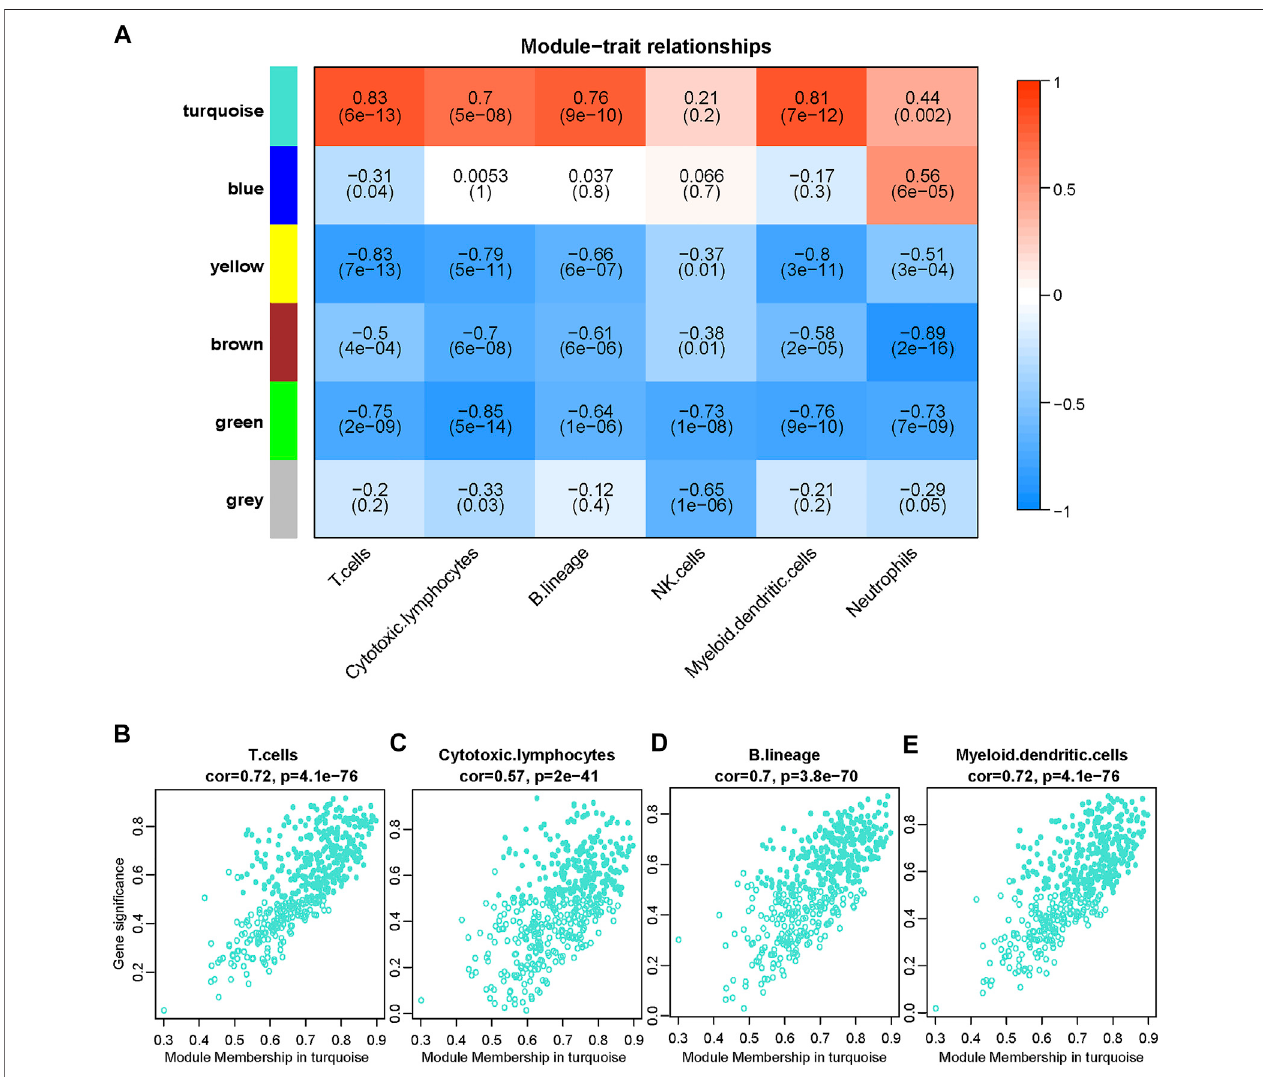
FIGURE 4 | Screening candidate immune-related DN biomarkers using WGCNA. (A) Correlation between the gene module and in fi ltrated immune cell population, which signi fi cantly differed between the DN and healthy samples. The correlation coef fi cient in each cell represented the correlation between the gene module and the in fi ltrated immune cell, which decreased in color from red to blue. The corresponding p value is also annotated. (B – E) Scatter plots depict the relationship between module membership (MM) and gene signi fi cance (GS) in the turquoise module. Genes with MM ≥ 0.5 and GS ≥ 0.5 are labeled with solid dots.